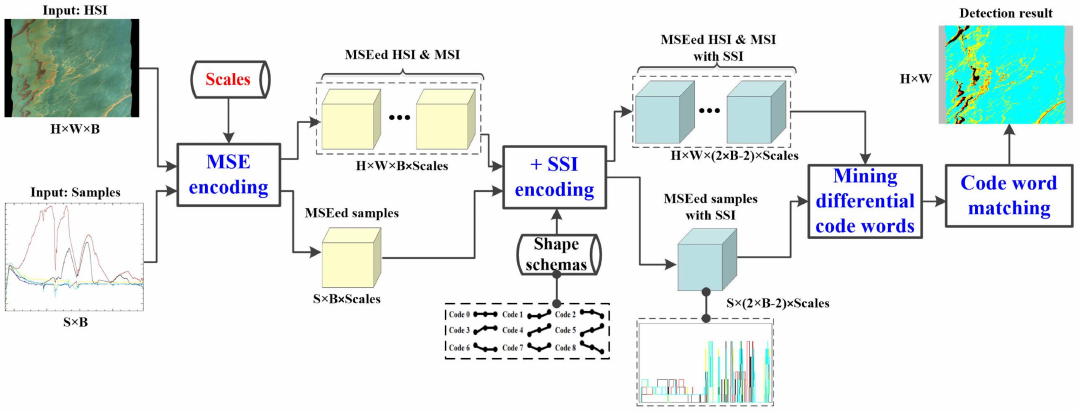
Figure 4. The flow chart of the ground object detection by the MSE method with